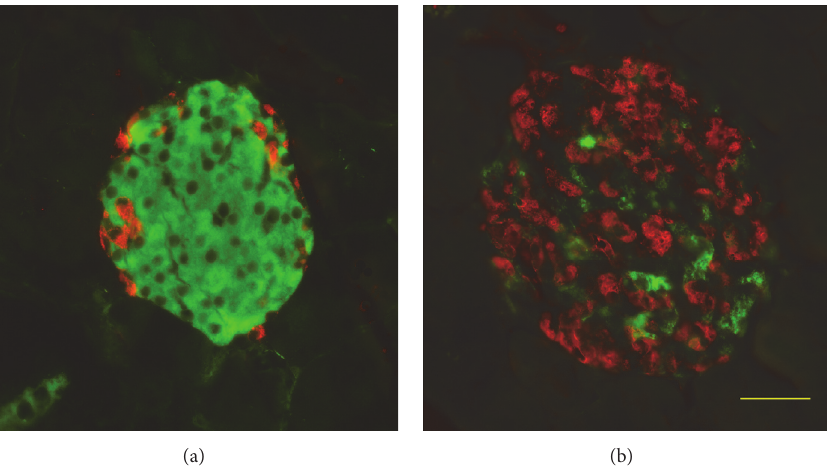
Figure 3: Coimmunostaining for insulin and glucagon of islets. Pancreas sections from wild-type (a) and Tg (b) mice at 40 weeks of age costained with antibodies to insulin (green) and glucagon (red). Bar, 40 𝜇 m.